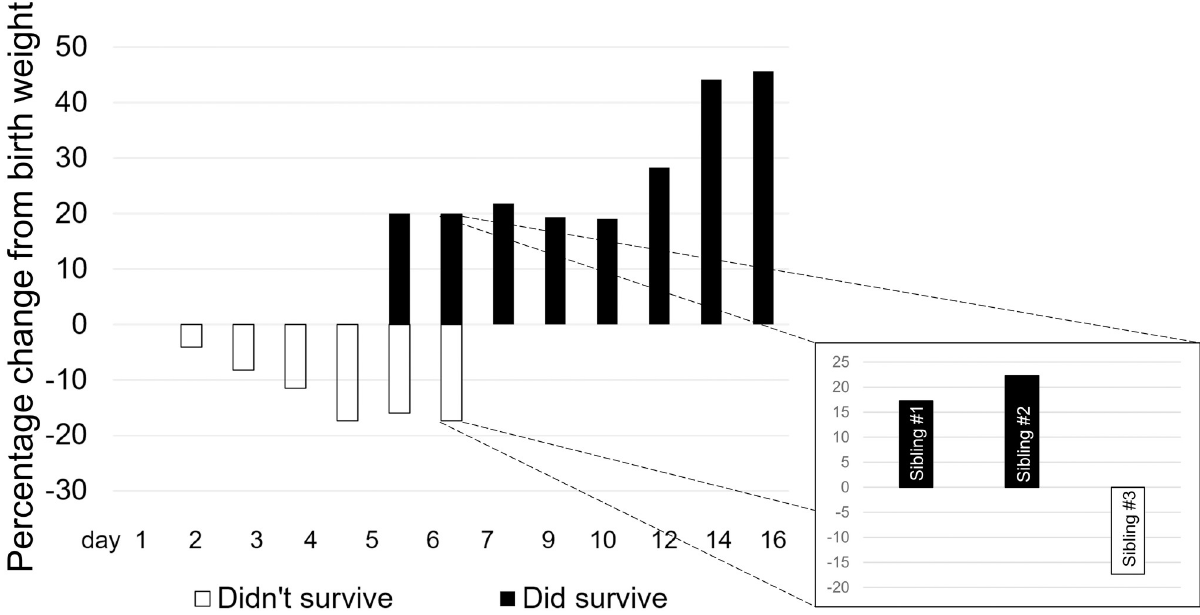
Fig 2. Comparison of weight change in F1 infants who died in the first week (n = 34) and those who survived (n = 11). Inset: comparison of weight change for one triplet litter with one loss and recorded weights for all siblings on day